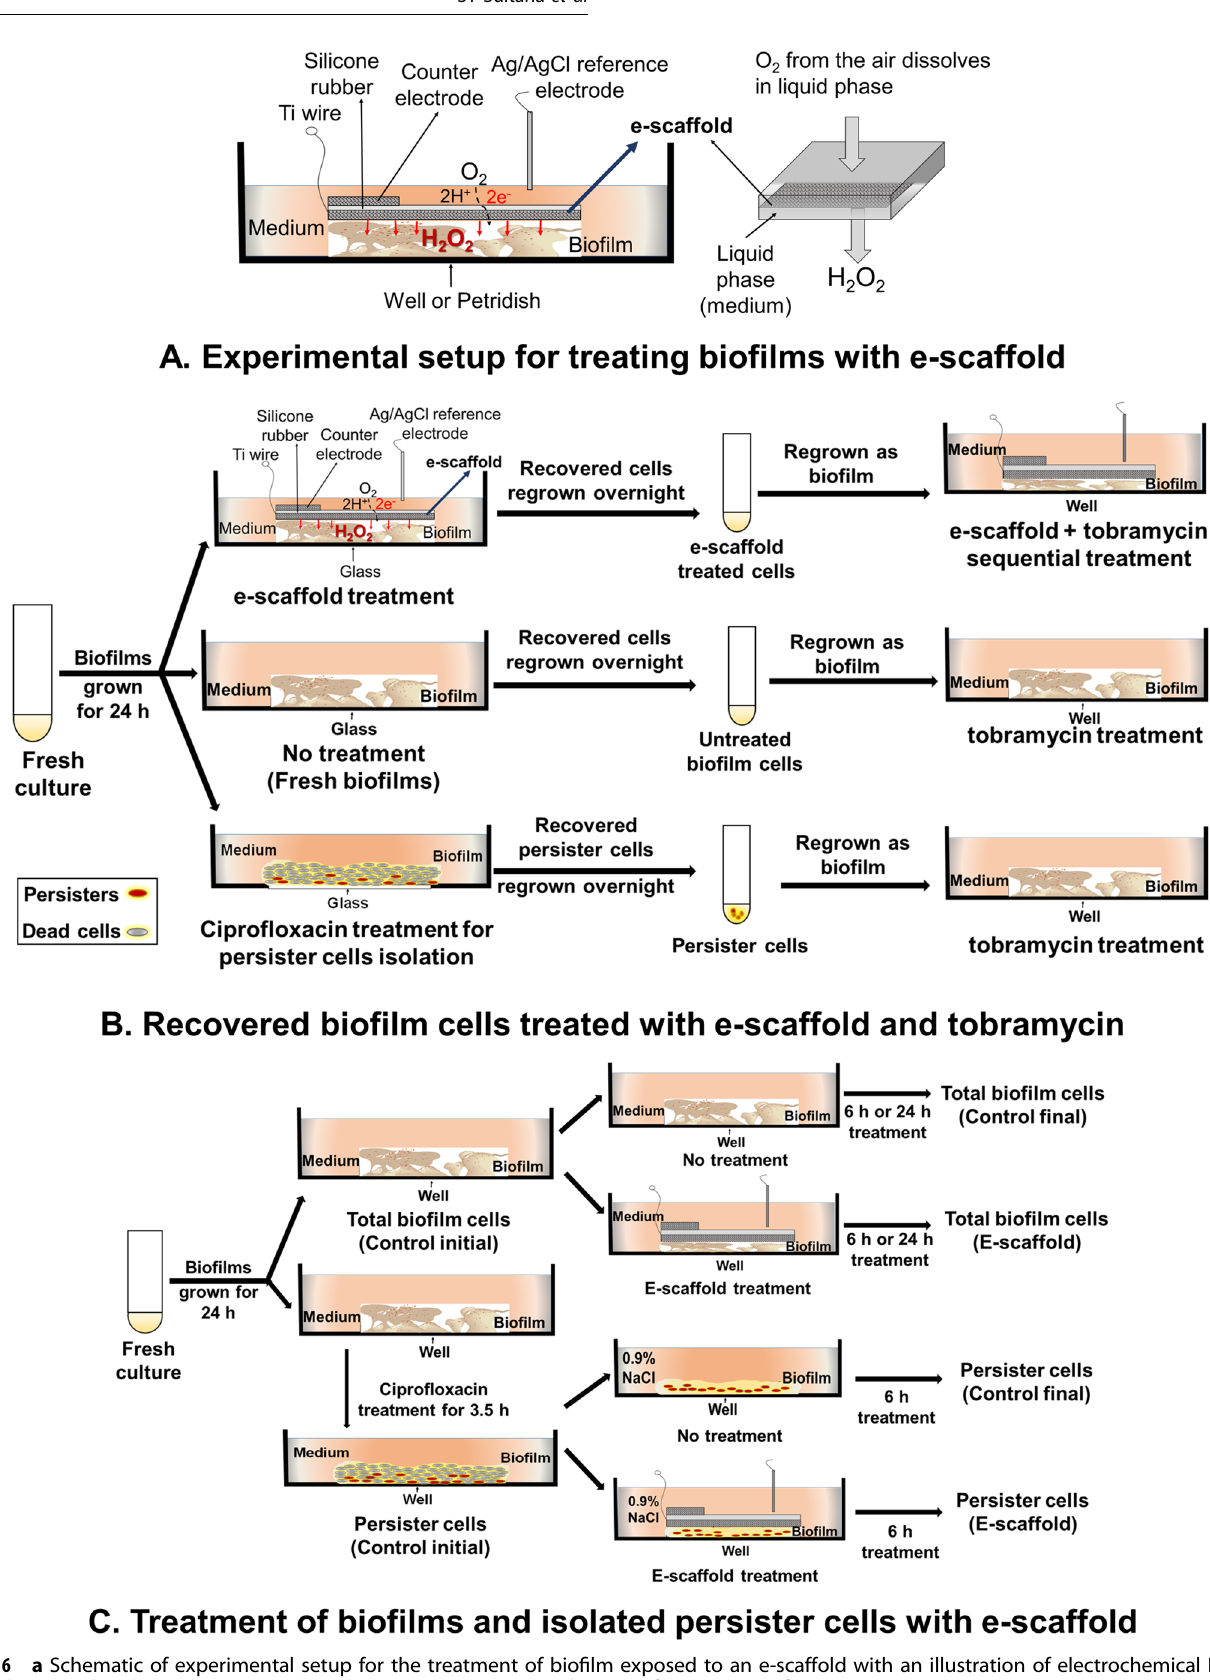
Fig. 6 a Schematic of experimental setup for the treatment of bio fi lm exposed to an e-scaffold with an illustration of electrochemical H 2 O 2 production. The electrodes are connected to a potentiostat (not shown in fi gure). Scienti fi c Reports, 2015. 5, 14908. DOI: